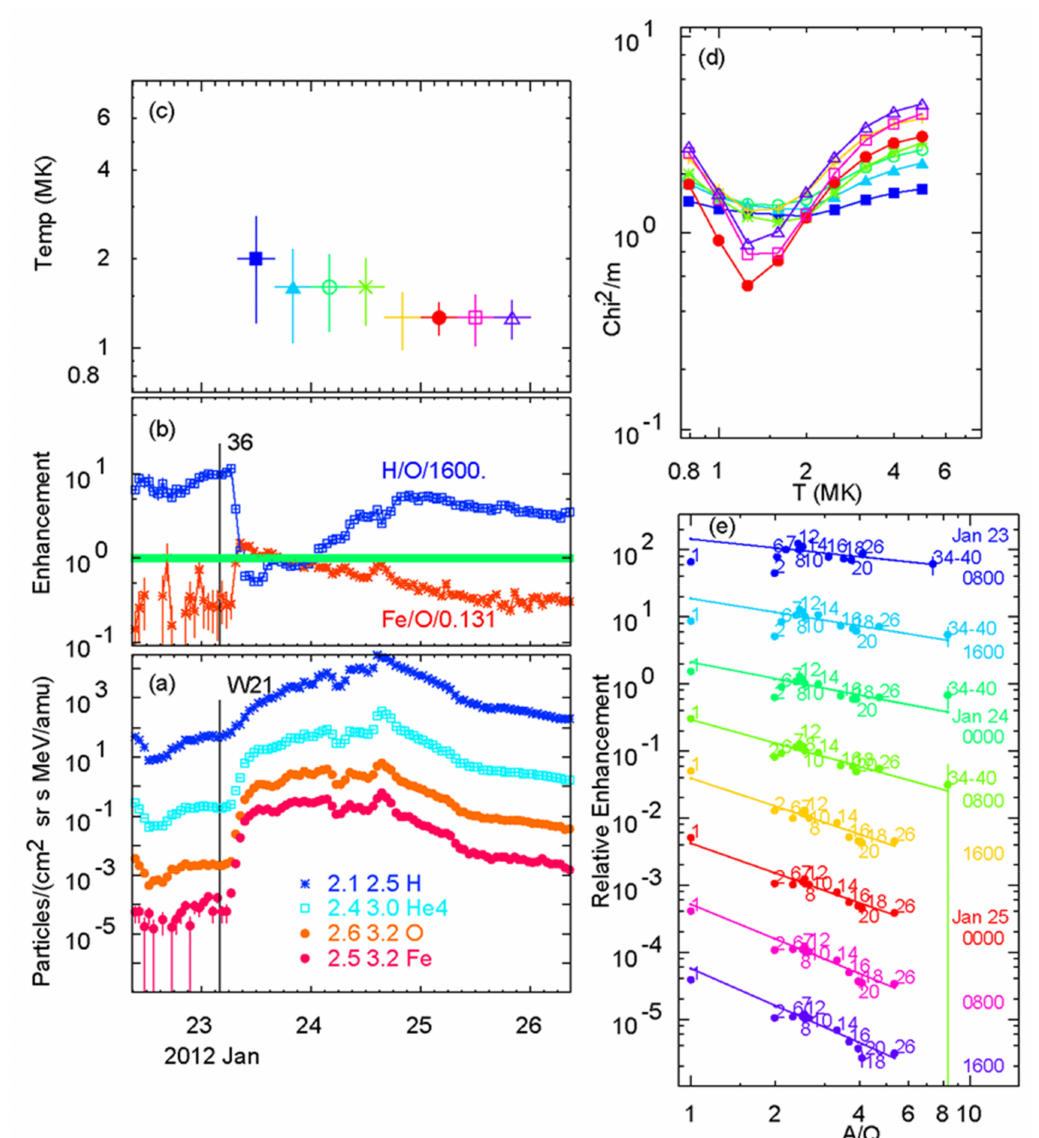
Figure 5. ( a ) Intensities of H, He, O, and Fe vs. time. ( b ) Normalized abundance enhancements H/O and Fe/O vs. time. ( c ) Best-fit temperatures vs. time for the 23 January 2012 SEP event. ( d ) χ 2 / m vs. T for each 8 h interval. ( e ) Enhancements, labeled by Z , v vs. A/Q for each 8 h interval shifted × 0.1, with best-fit power law for elements with Z ≥ 6 extrapolated down to H at A/Q = 1. Colors correspond for the eight intervals in ( c – e ) and symbols in ( c , d ); times are also listed in ( e ). Event onset is flagged with solar longitude in ( a ) and the event number from the list of 45 events [113] in ( b )